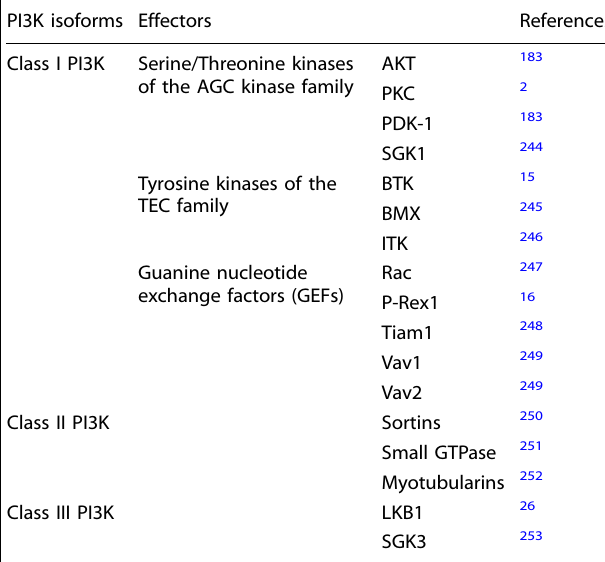
Table 1. Different effectors of class I, II and III